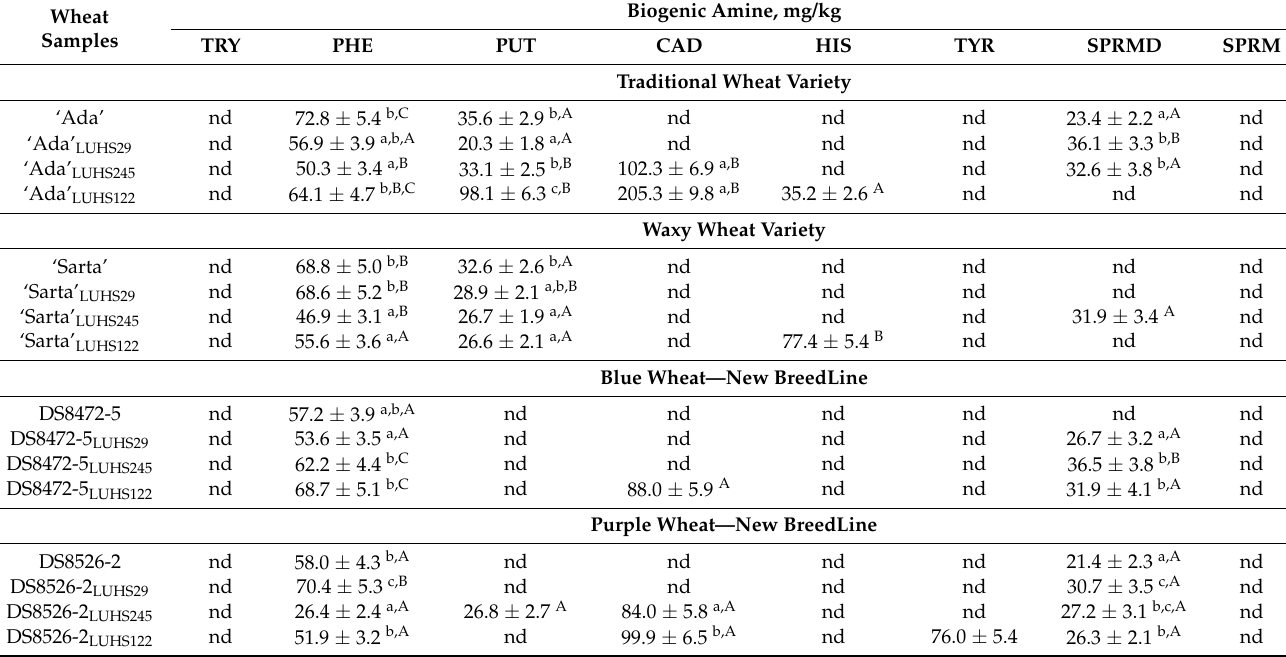
Table 2. Biogenic amine concentration (mg/kg) in wheat wholemeal samples. Wheat